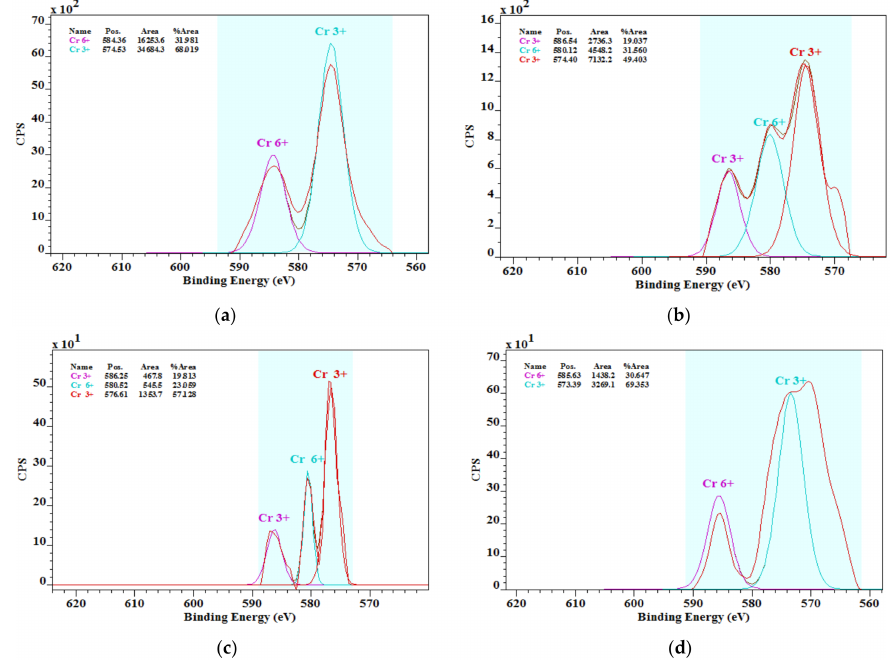
Figure 4. X-ray photoelectron spectroscopy (XPS) spectra of ( a ) OPC1; ( b ) OPC2; ( c ) OPC3; and ( d )